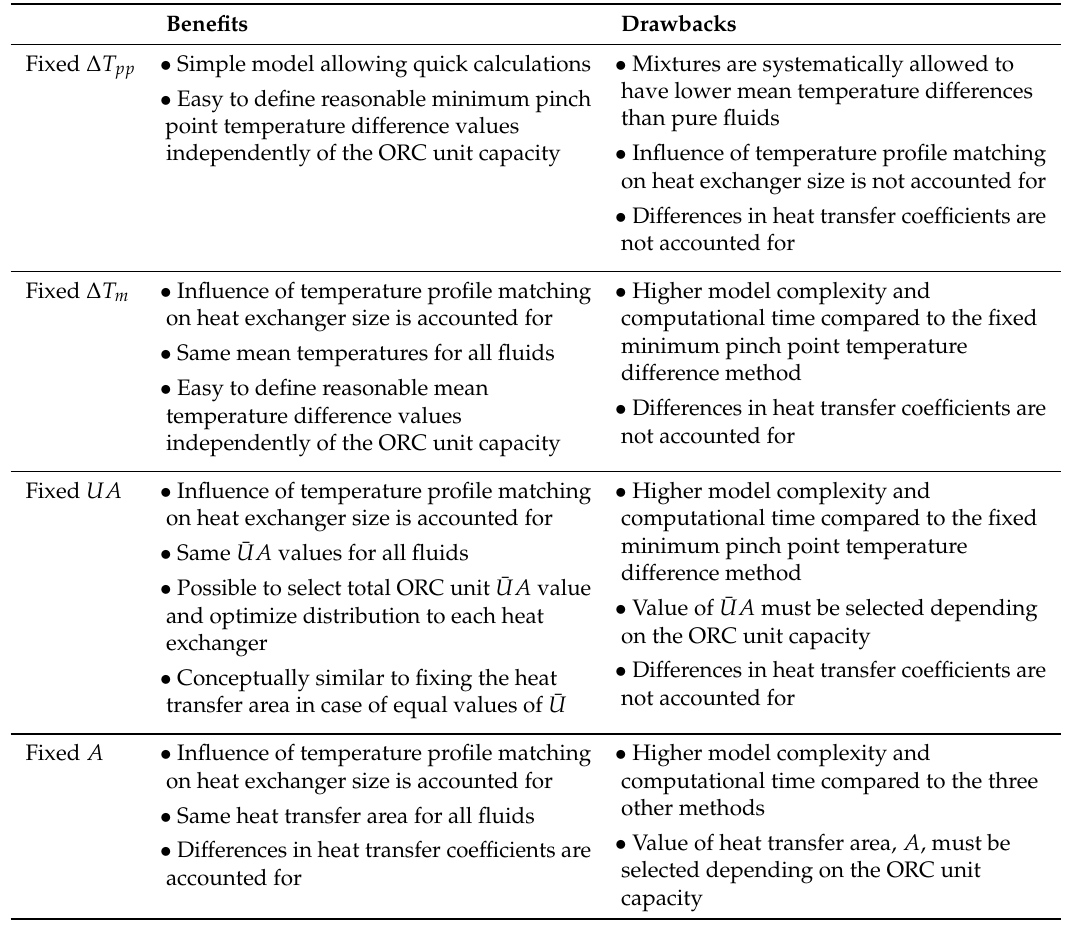
Table 6. Method assessment